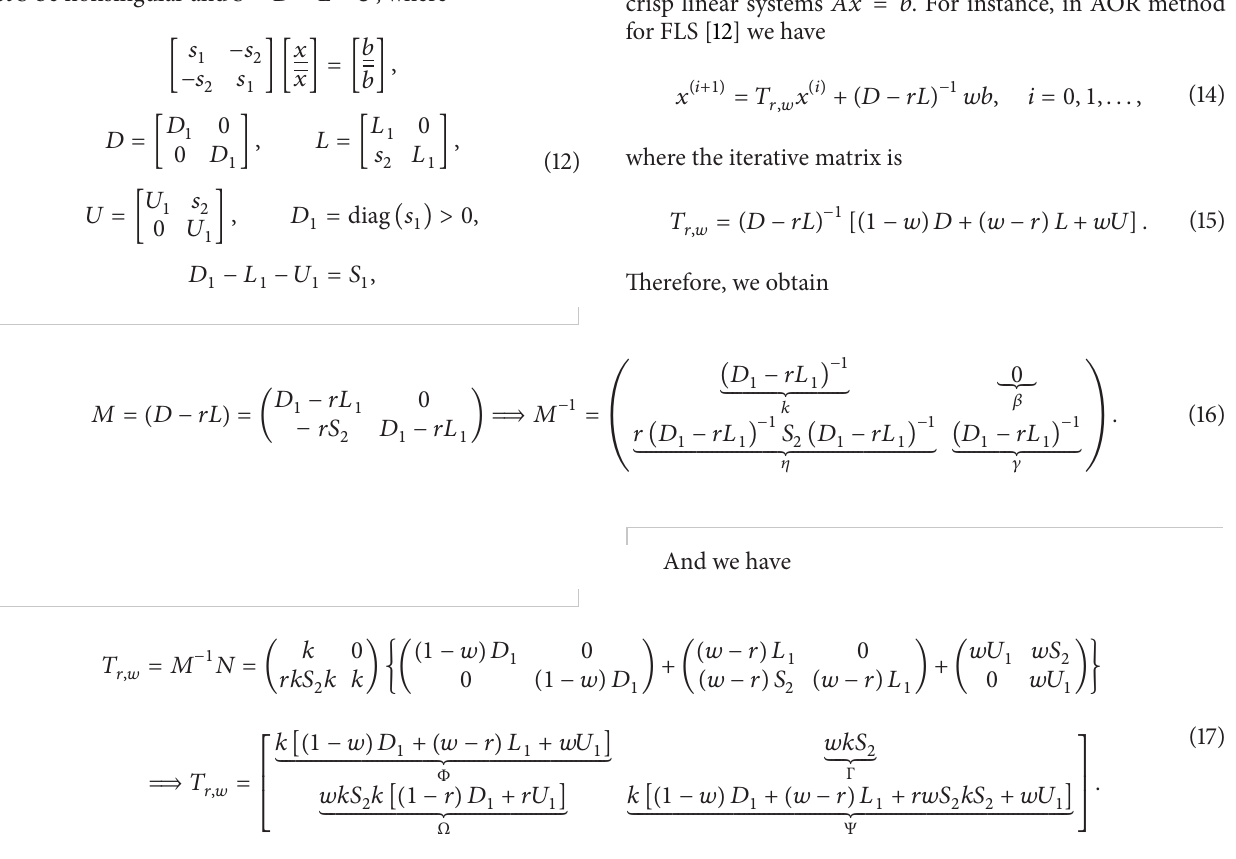
Algorithm 9. AOR iterative method for